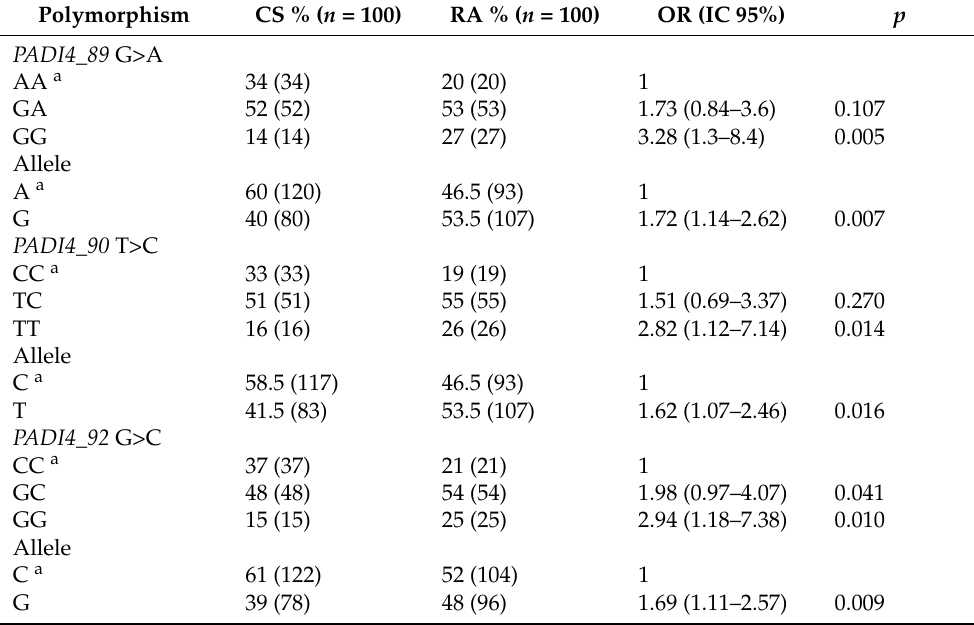
Table 2. Genotypic and allelic frequency of PADI4 polymorphisms in RA patients and CS.